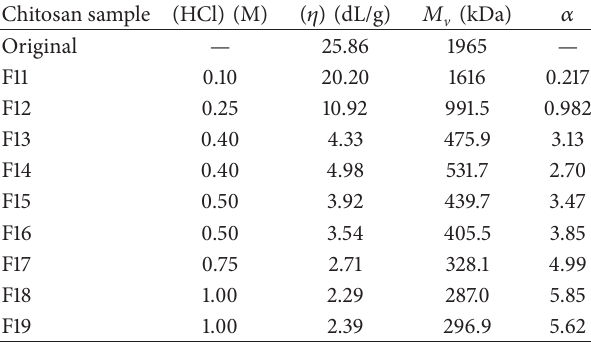
Table 2: The intrinsic viscosity, ( 𝜂 ), the viscosity-average molecular weight, 𝑀 V , and the average number of chain scissions ( 𝛼 ) for the fragments prepared by hydrolysis of 1.0% chitosan with different HCl concentrations at 65 ∘ C for